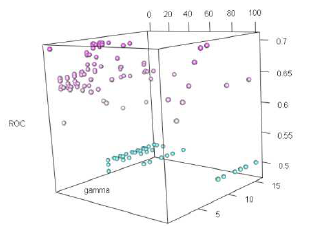
Figure 3. Hyperparameters with respect to